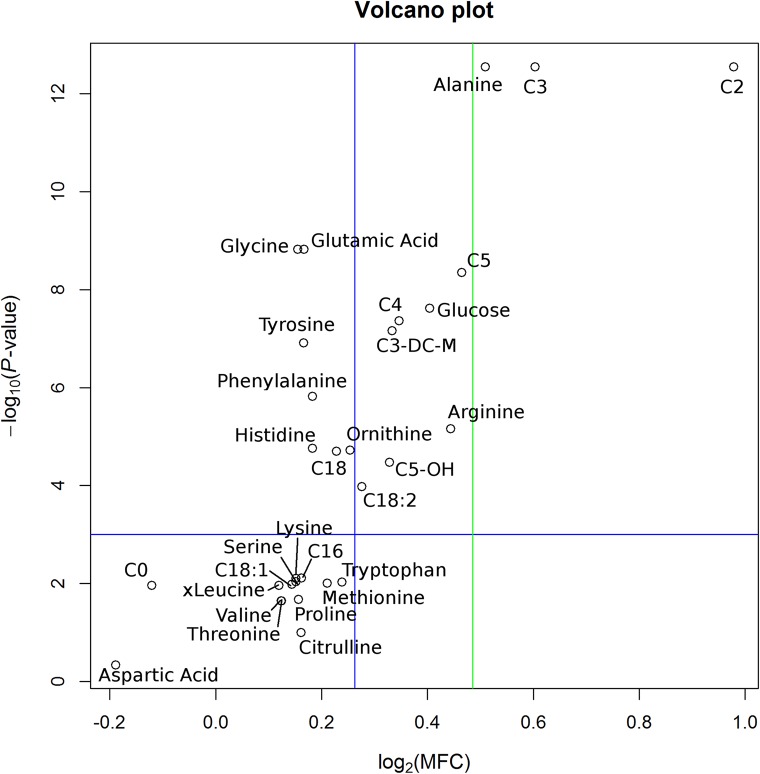
Volcano plot.The volcano plot displays the log2(MFC) between minimum and maximum concentrations values versus the-log10(P-value) calculated from statistical hypothesis testing. The horizontal blue line indicates the selected significance level of 0.001. The vertical blue line indicates the threshold for classification as moderate predictor (MFC > 1.20). The vertical green line denotes the classification threshold for a strong predictor (MFC > 1.40). Acetylcarnitine (C2), propionylcarnitine (C3) and alanine could be selected as strong biomarker candidates. Valerylcarnitine (C5), arginine, glucose, butyrylcarnitine (C4), methylmalonylcarnitine (C3-DC-M), and hydroxyvalerylcarnitine (C5-OH) were identified as moderate biomarker candidates.